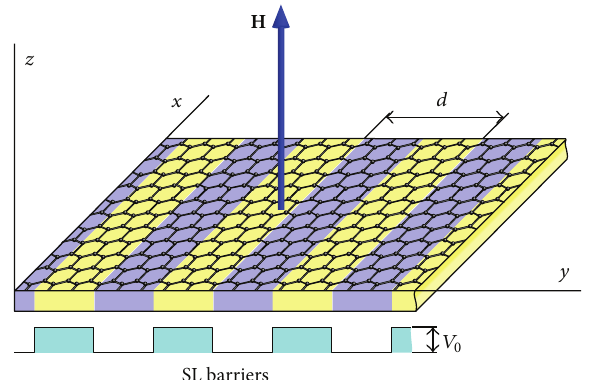
Figure 1: Schematic of the studied